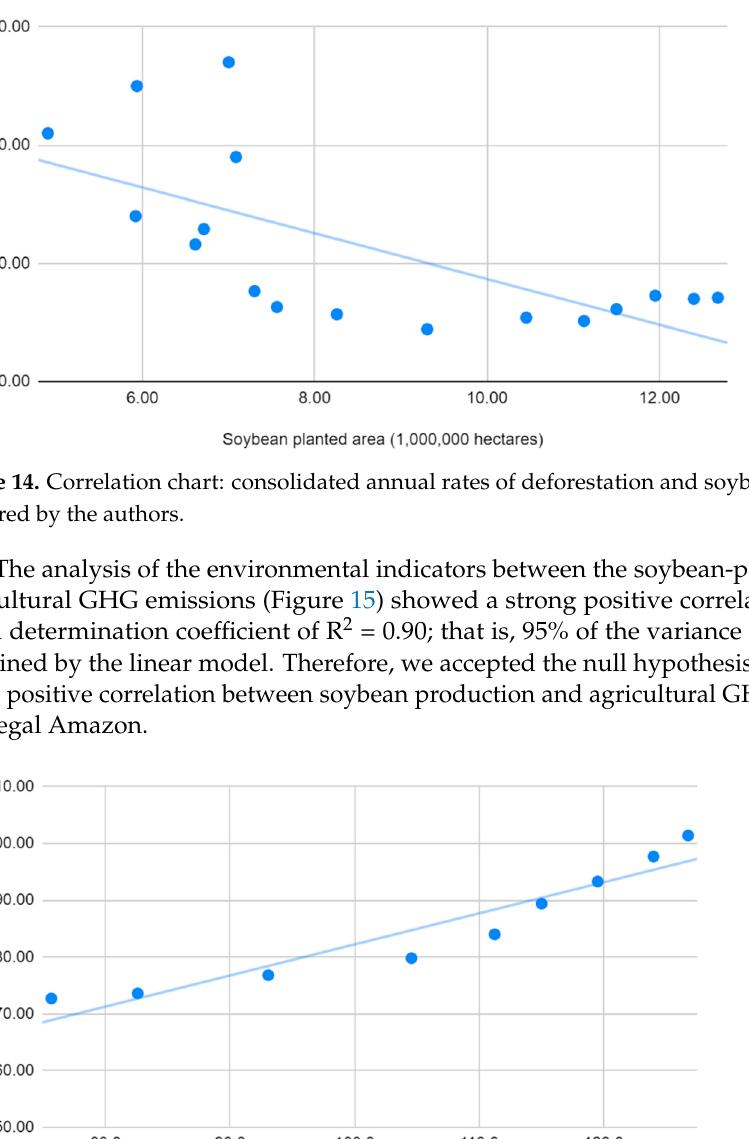
20 Figure 12. Correlation chart: per capita GDP and soybean production. Prepared by the authors. In the analysis between soybean production and the added value of the services to the GDP (the value of added services at current prices with the exceptions of except ad- ministration, defense, education, and public health and social security (Figure 13)), ob- served a strong positive r correlation and a coefficient of determination of 𝑅 (cid:2870) = 0.947. Therefore, we accepted the null hypothesis (H1) that there was a correlation between soy- bean production and the added value of the services to the GDP in the Legal Amazon. Figure 13. Correlation chart: added value of the services to GDP and soybean production. Pre- pared by the authors. In the analysis of environmental indicators between the soybean-planted area and